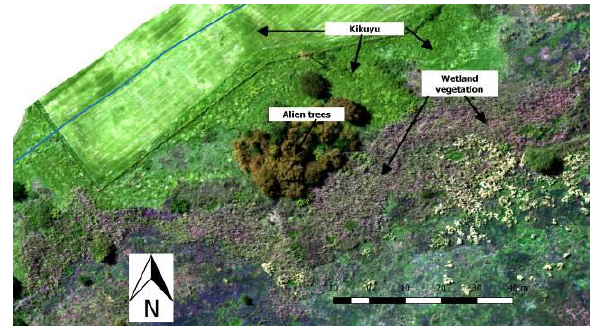
Figure 8. Vegetation extents within the wetland.